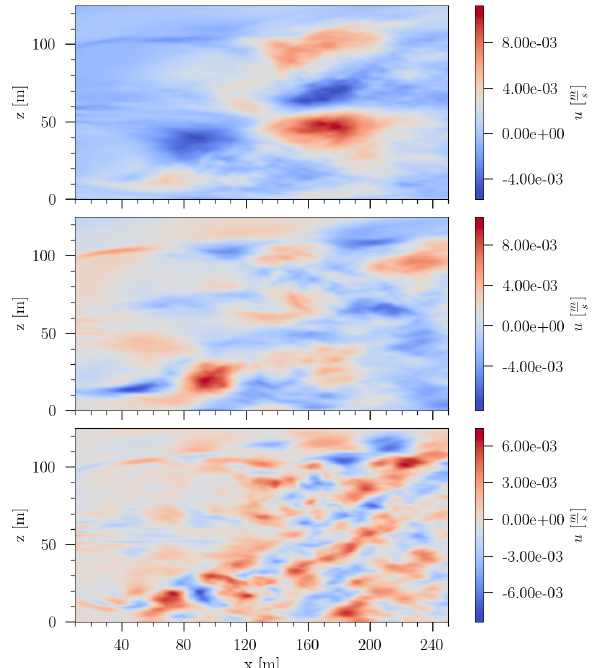
Figure 19. Visualization of three different POD modes of the near wake for the wind turbine case. From top to bottom: mode 1, 5 and 15,